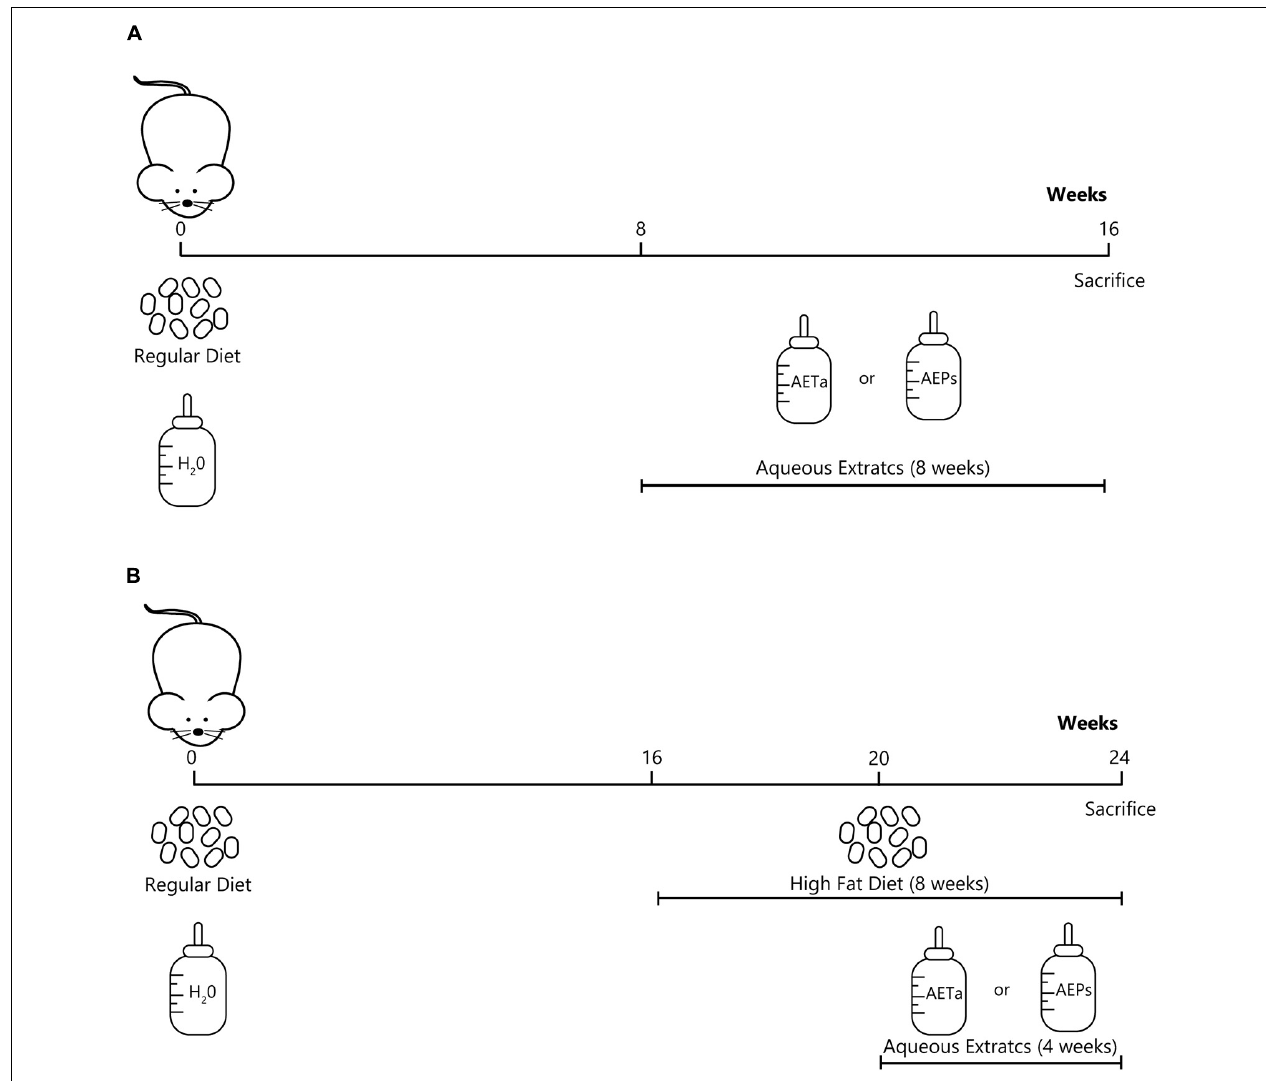
SCHEME 1 | Experimental design showing the groups of animals, the type of diets and study-time points (weeks). (A) Scheme to evaluate the effects of P. strombulifera or T. absinthioides on biochemical parameters, and their role on preventing oxidative stress. (B) Scheme to assess the role of P. strombulifera or T. absinthioides on high-fat diet-induced atheroma